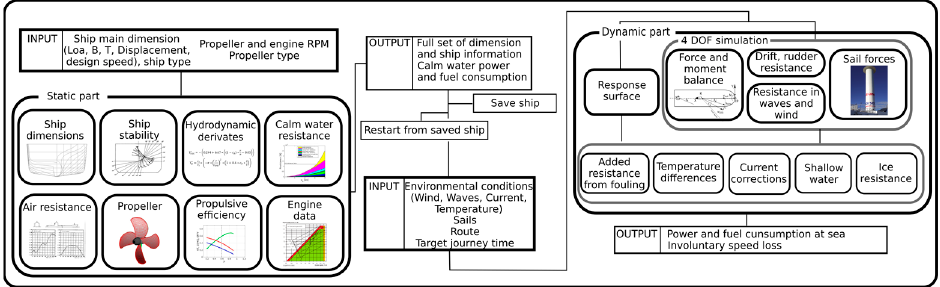
Figure 4. Overview of the ShipCLEAN model.